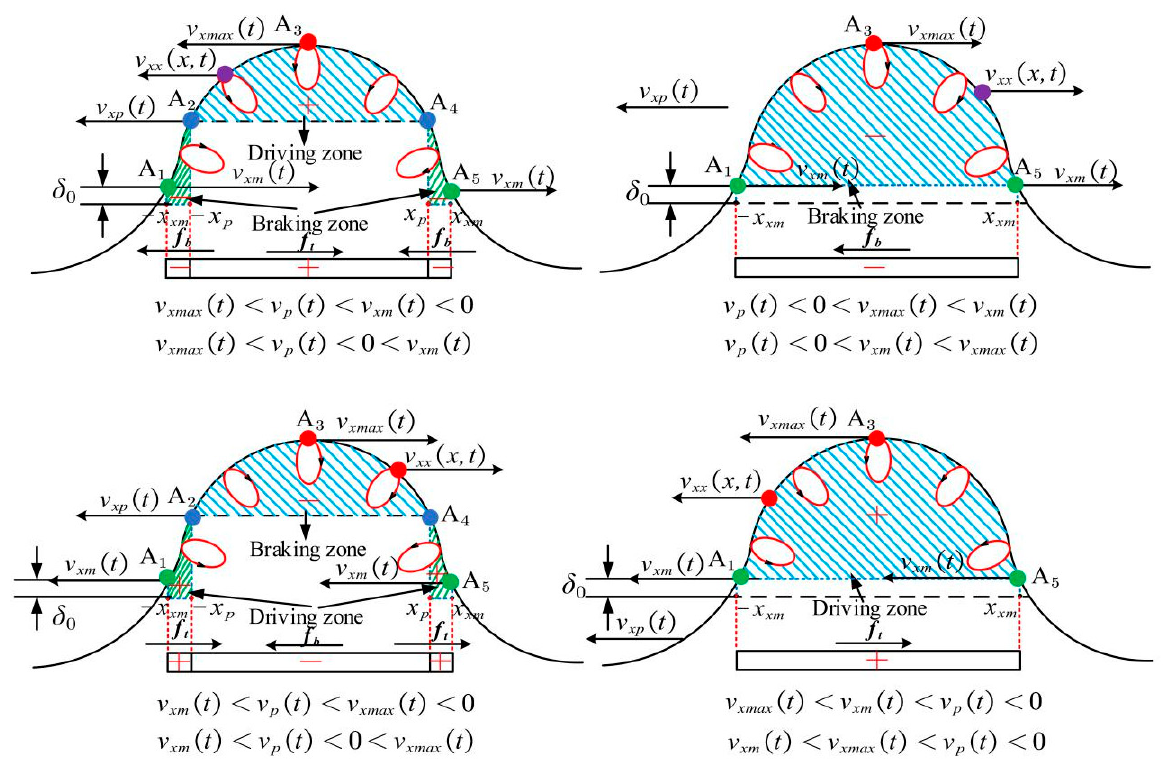
Figure 8. Reverse sliding point transfer model.